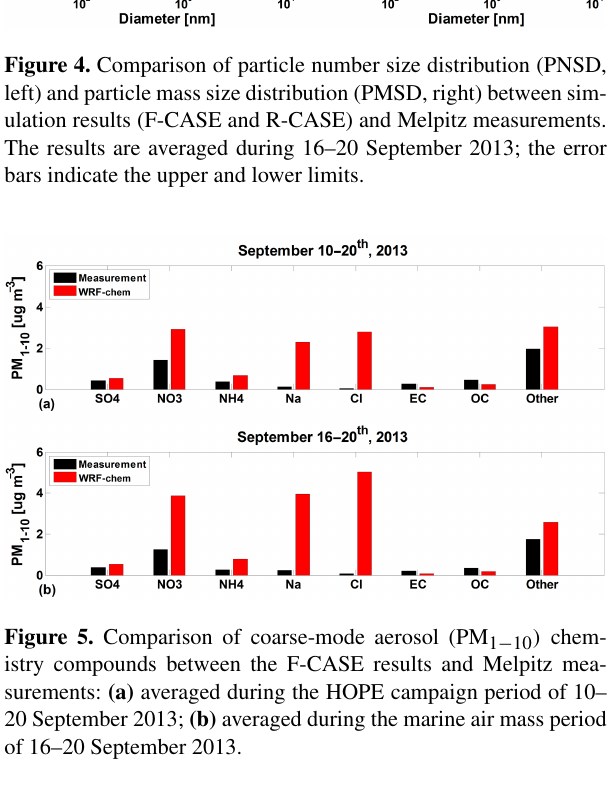
of 16–20 September